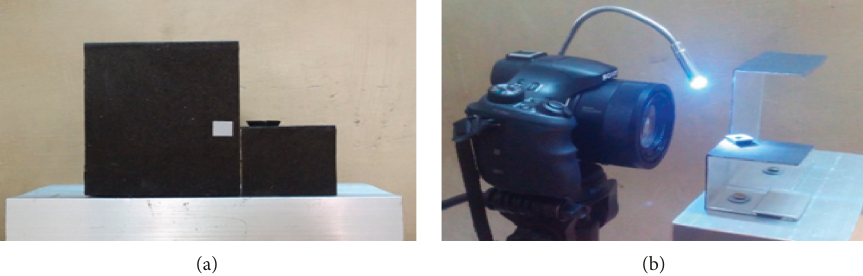
Figure 2: (a) Fixture for positioning of the tool insert and calibration square; (b) set up for the vision system.